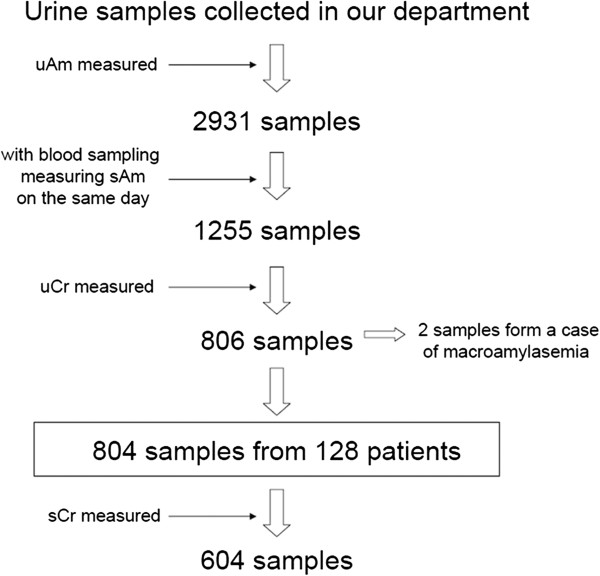
A flow chart of data collection.